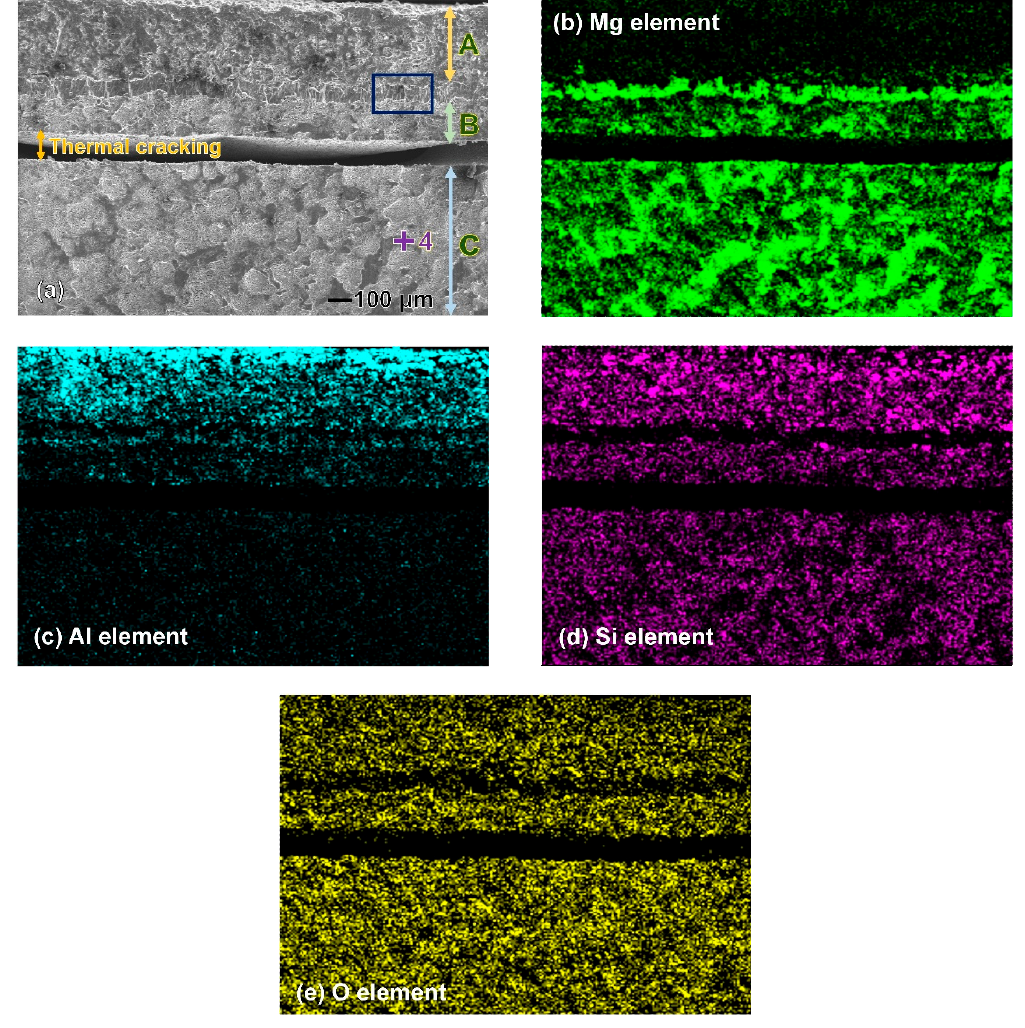
Figure 11. ( a ) Cross-sectional SEM micrographs, ( b – e ) and the corresponding elemental mappings (Mg, Al, Si and O K α ) of the damaged Comps2 coating after 216 thermal cycles in condition I.